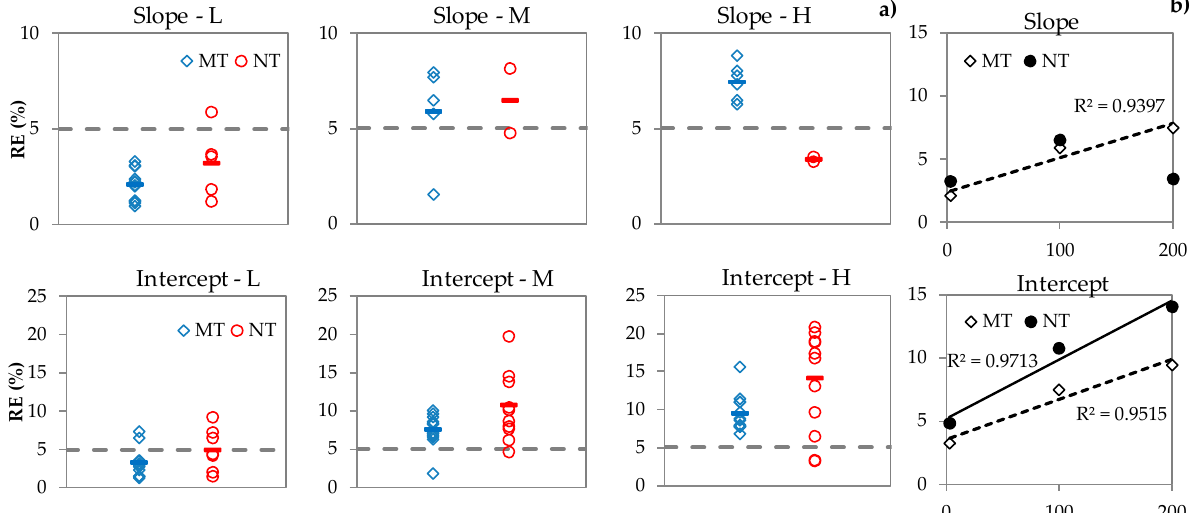
Figure 2. Success rate in obtaining a water retention curve with BEST-slope and BEST-intercept/steady for different heights of water pouring (high, H; intermediate, M; low, L) and soil management practices (minimum tillage, MT; no-tillage, NT). The percentages are related to the total sample size, n = 36.